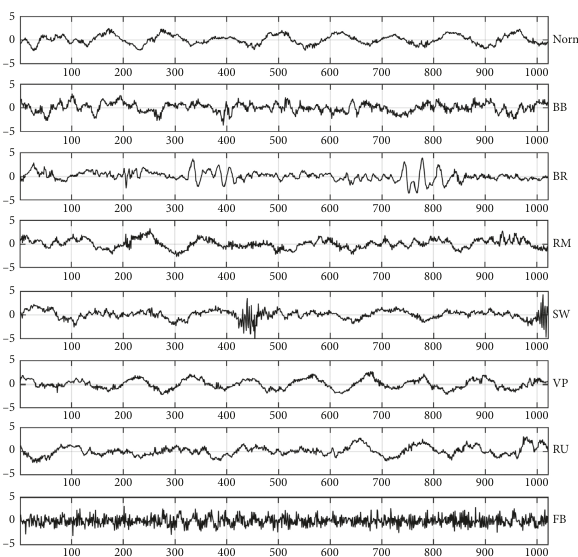
Figure 2: The waveforms of the measured acceleration signals of 8